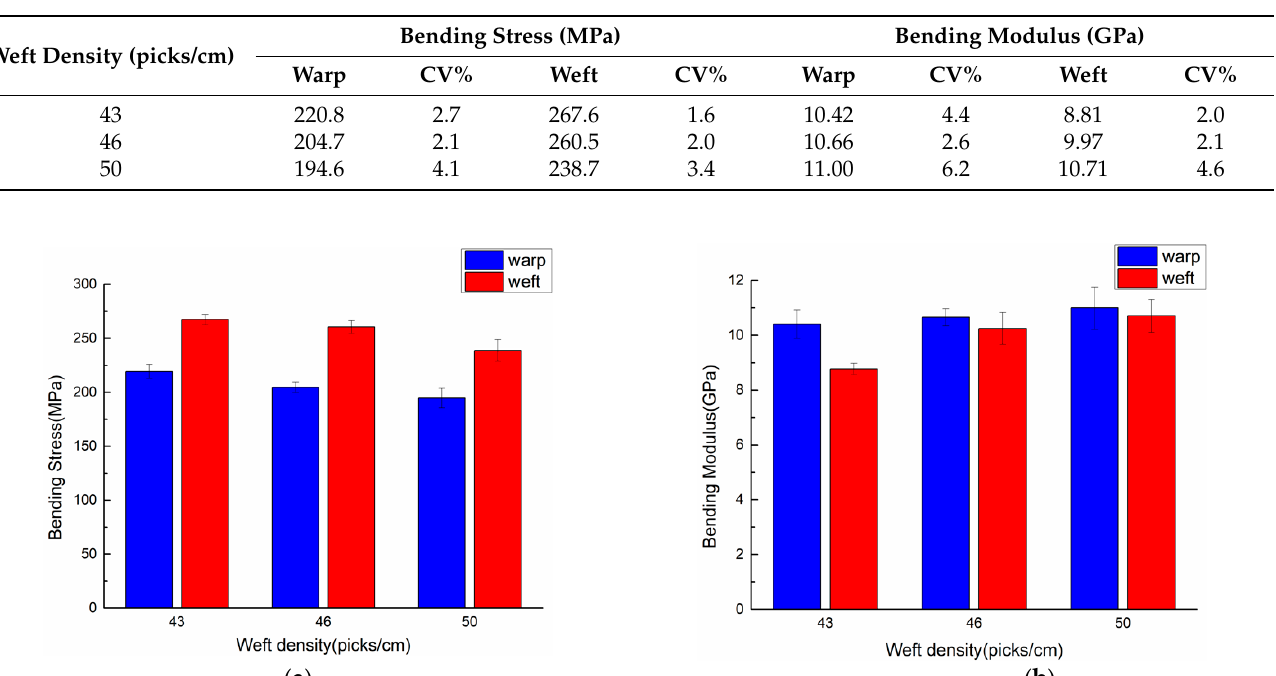
Figure 11. Comparison of the bending performance of materials with different laying method. ( a ) Strength coefficient. ( b ) Stiffness coefficient.